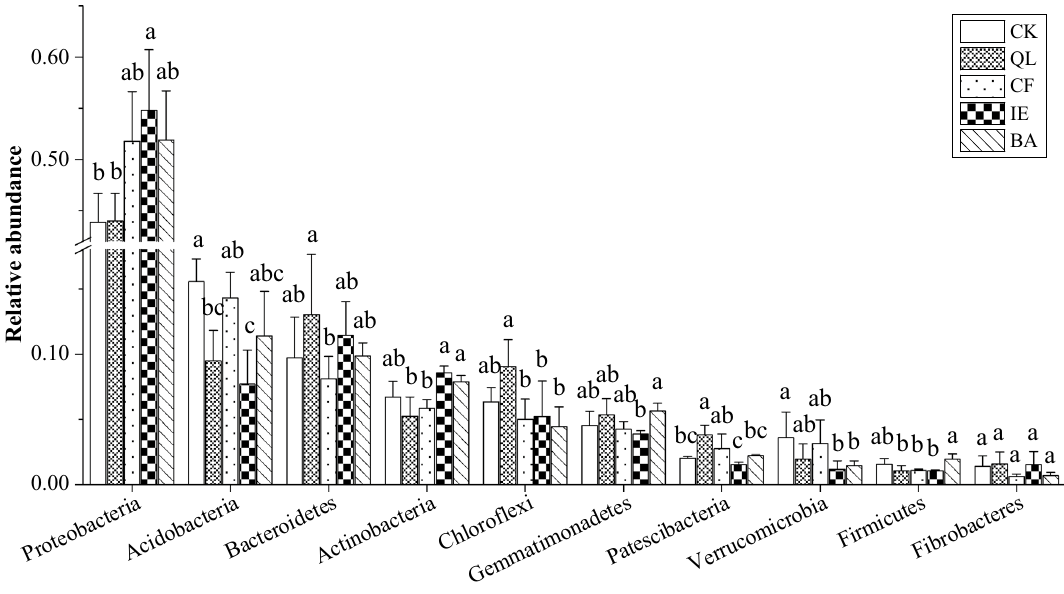
Figure 5. Relative abundance of the top ten dominant bacterial phyla of rhizosphere soil in continuous cropping lily. Bars indicate standard error (n = 3). Different letters above columns within the same species indicate significance at p < 0.05 according to Duncan test. CK blank control, QL quicklime, CF chemical fungicide, IE inoculation with earthworms, BA biocontrol Betaproteobacteriales (10.22%) , Rhizobiales (8.38%) , Myxococcales (6.97%) , Gammaproteobacteria_Incertae_Sedis (3.55%) , Flavobacteriales (2.42%) , Micrococcales (2.09%) , Steroidobacterales (1.64%) , Streptomycetales (1.44%), and Pseudomonadales (1.28%) , with a significantly (p < 0.05) higher abundance of Betaproteobacteriales, Rhizo- biales, and Micrococcales than with CK (7.11%, 6.26%, and 0.99%, respectively; Fig. 6B; Fig. S3). However, IE had the lowest relative abundance (> 1%) for the orders Gemmatimonadales (3.81%), Acidobacteriales (1.61%) , Sphingobacteriales (2.01%) and Saccharimonadales (1.31%), with a significantly lower abundance of Acidobac- teriales ( p < 0.05) than with CK (5.24%; Fig. 6B). Relationships between lily rhizosphere soil properties and bacterial community. To investi- gate correlations between rhizosphere soil properties and the bacterial community of continuous cropping lily under different treatments, redundancy analysis (RDA) was performed at the order level (Fig. 7). The results showed that the cumulative amount of explained variation in the first (41.6%) and second (13.79%) axes reached 55.39%. Betaproteobacteriales, Sphingomonadales and Xanthomonadales were significantly ( p < 0.05) positively